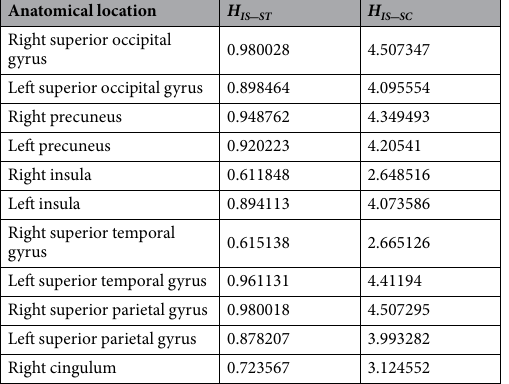
Table 2. Scale-integrated hubs ( H IS ) (scale-integrated hub score ( H IS _ SC ) > 1). Anatomical locations of the top 11 H IS that had an H IS _ SC one standard deviation above the